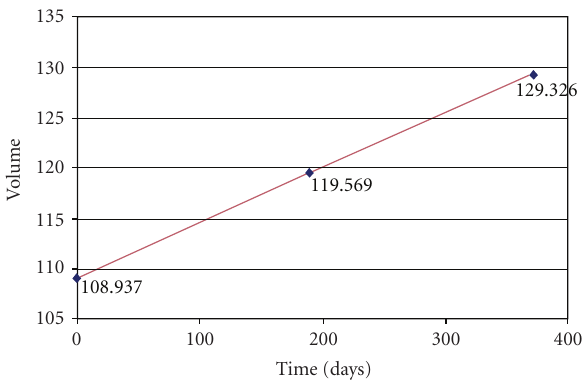
Figure 32: Patient 3. (a) 50 points on the contours, (b) 100 points on the contours, and (c) 200 points on the contours.